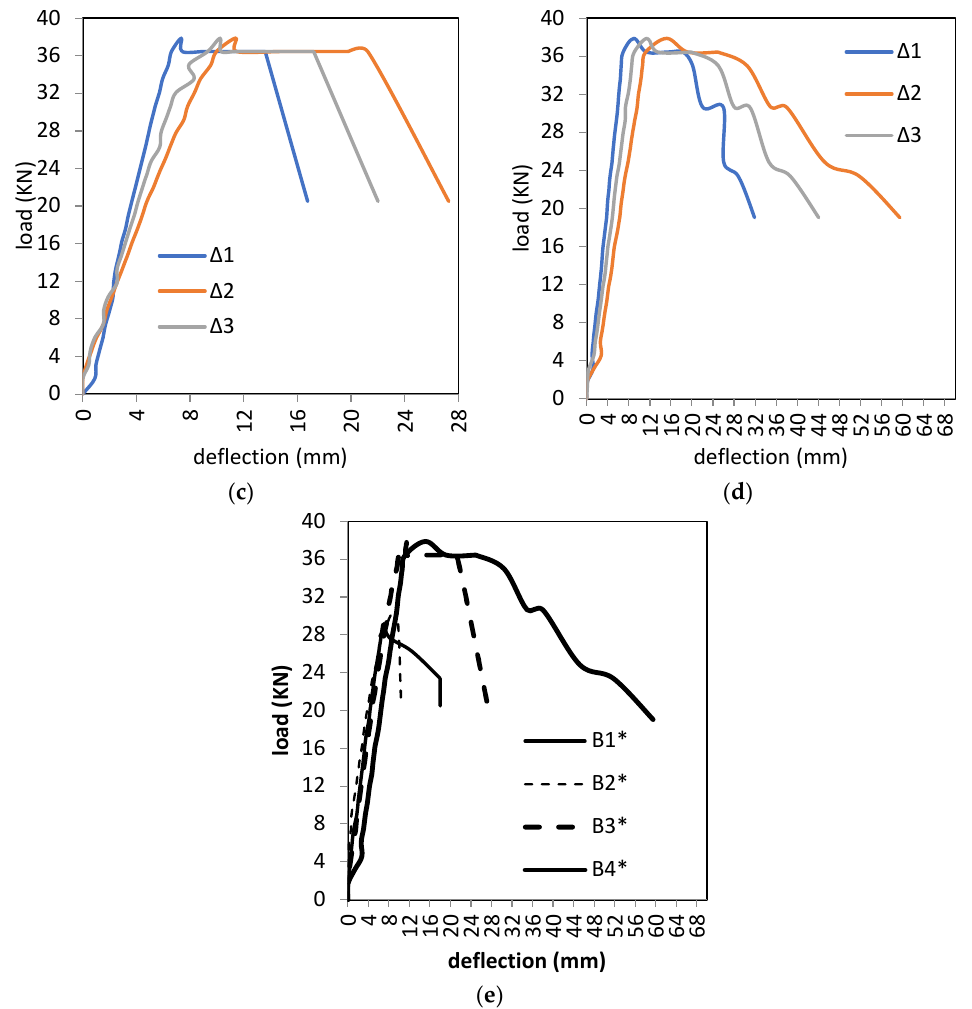
Figure 20. Load-deflection curves of beams of G2. ( a ) B1 *; ( b ) B2 *; ( c ) B3 *; ( d ) B4 *; ( e ) ∆2 for all beams of G2.